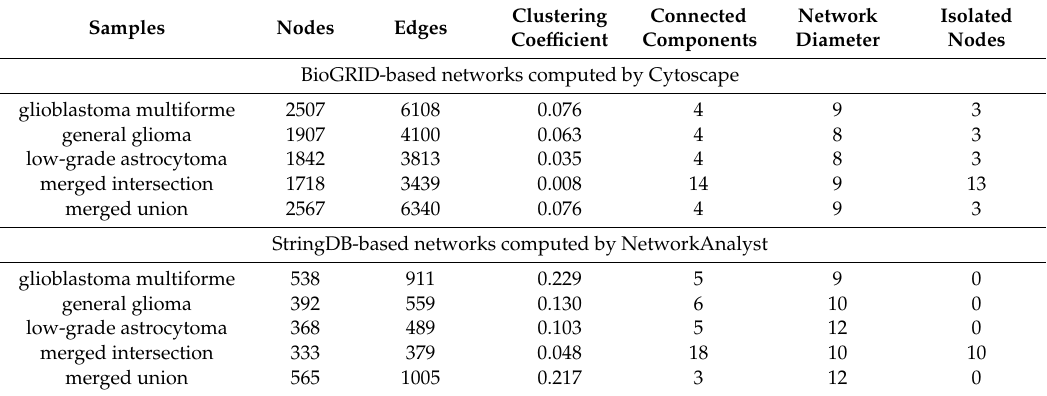
Table 1. Di ff erences between constructed networks from StringDB and BioGRID: counts of nodes and edges as well as cluster analysis. Clustering Connected Network Isolated Samples Nodes Edges Coe ffi cient Components Diameter Nodes BioGRID-based networks computed by Cytoscape glioblastoma